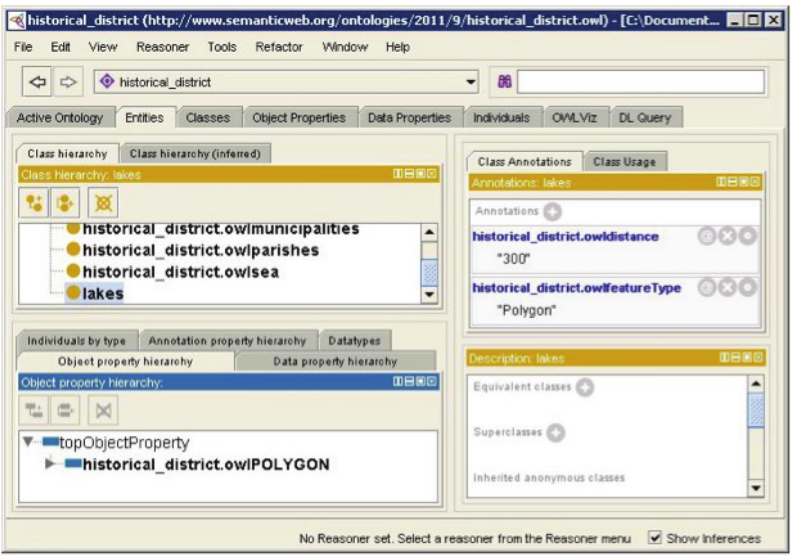
Figure 7: The semantics of each layer are defined in the prot´eg´e